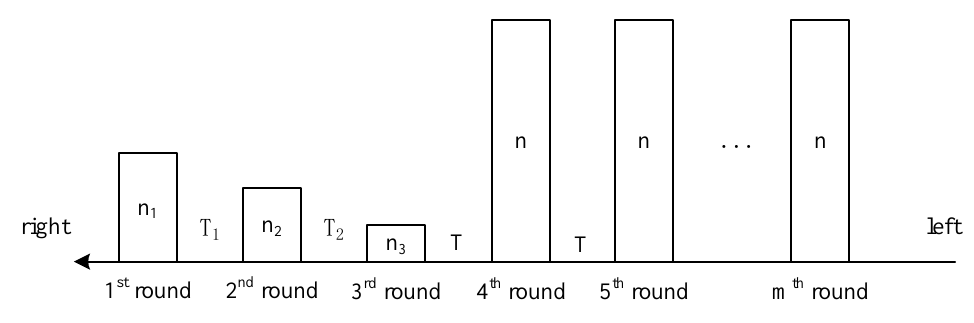
Figure 3. Multi-round tag recognition for conveyor belt systems.